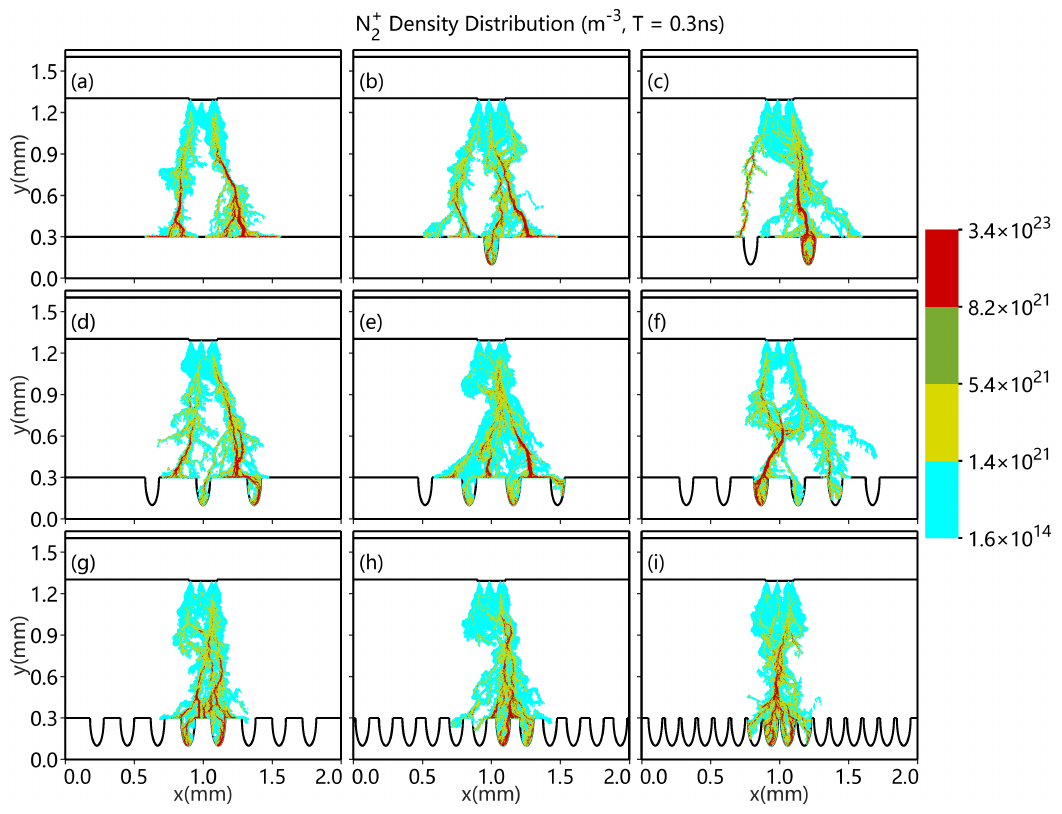
Figure 4. N + densities (m − 3 ) with different catalyst pore numbers at 0.3 ns in DBD with ε r = 4 for both 2 the top and bottom dielectric plates. The numbers of catalyst pores are 0 ( a ), 1 ( b ), 2 ( c ), 3 ( d ), 4 ( e ), 6 ( f ), 8 ( g ), 12 ( h ), and 16 ( i ). The diameter and depth of the catalyst pore are 0.1 mm and 0.2 mm, respectively. The voltage of the upper electrode ( y ∈ [ 1.60,1.65 ] mm) is − 20 kV, and the bottom electrode ( y = 0 mm) is